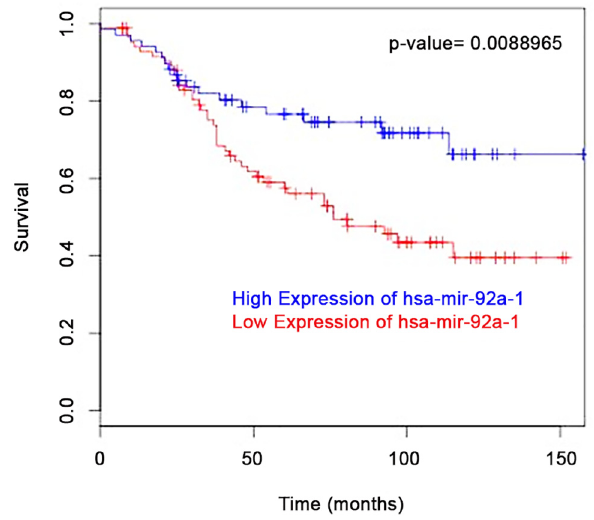
Fig 1. In silico analysis using BreastMark [26] shows luminal A breast cancer patients (n = 154) who express miR – 92 have improved disease free survival (DFS) rate compared to patients with low expression levels with a hazard ratio of 0.49 (95% confidence intervals 0.28 – 0.84; p =